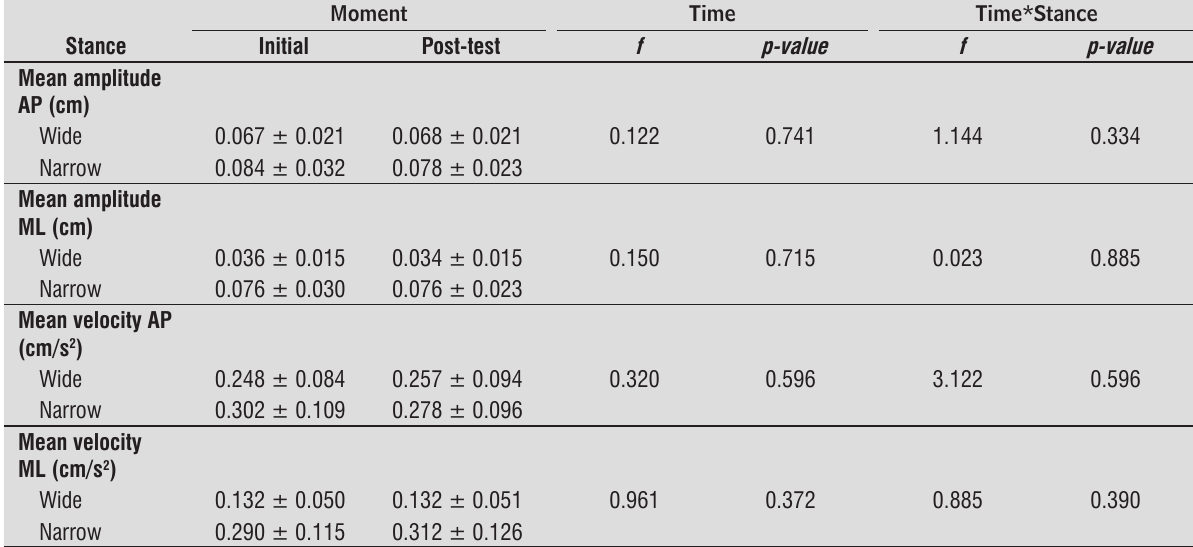
Table 2 - Mean and standard deviations of body sway, pre and post-exercise and narrow and wide